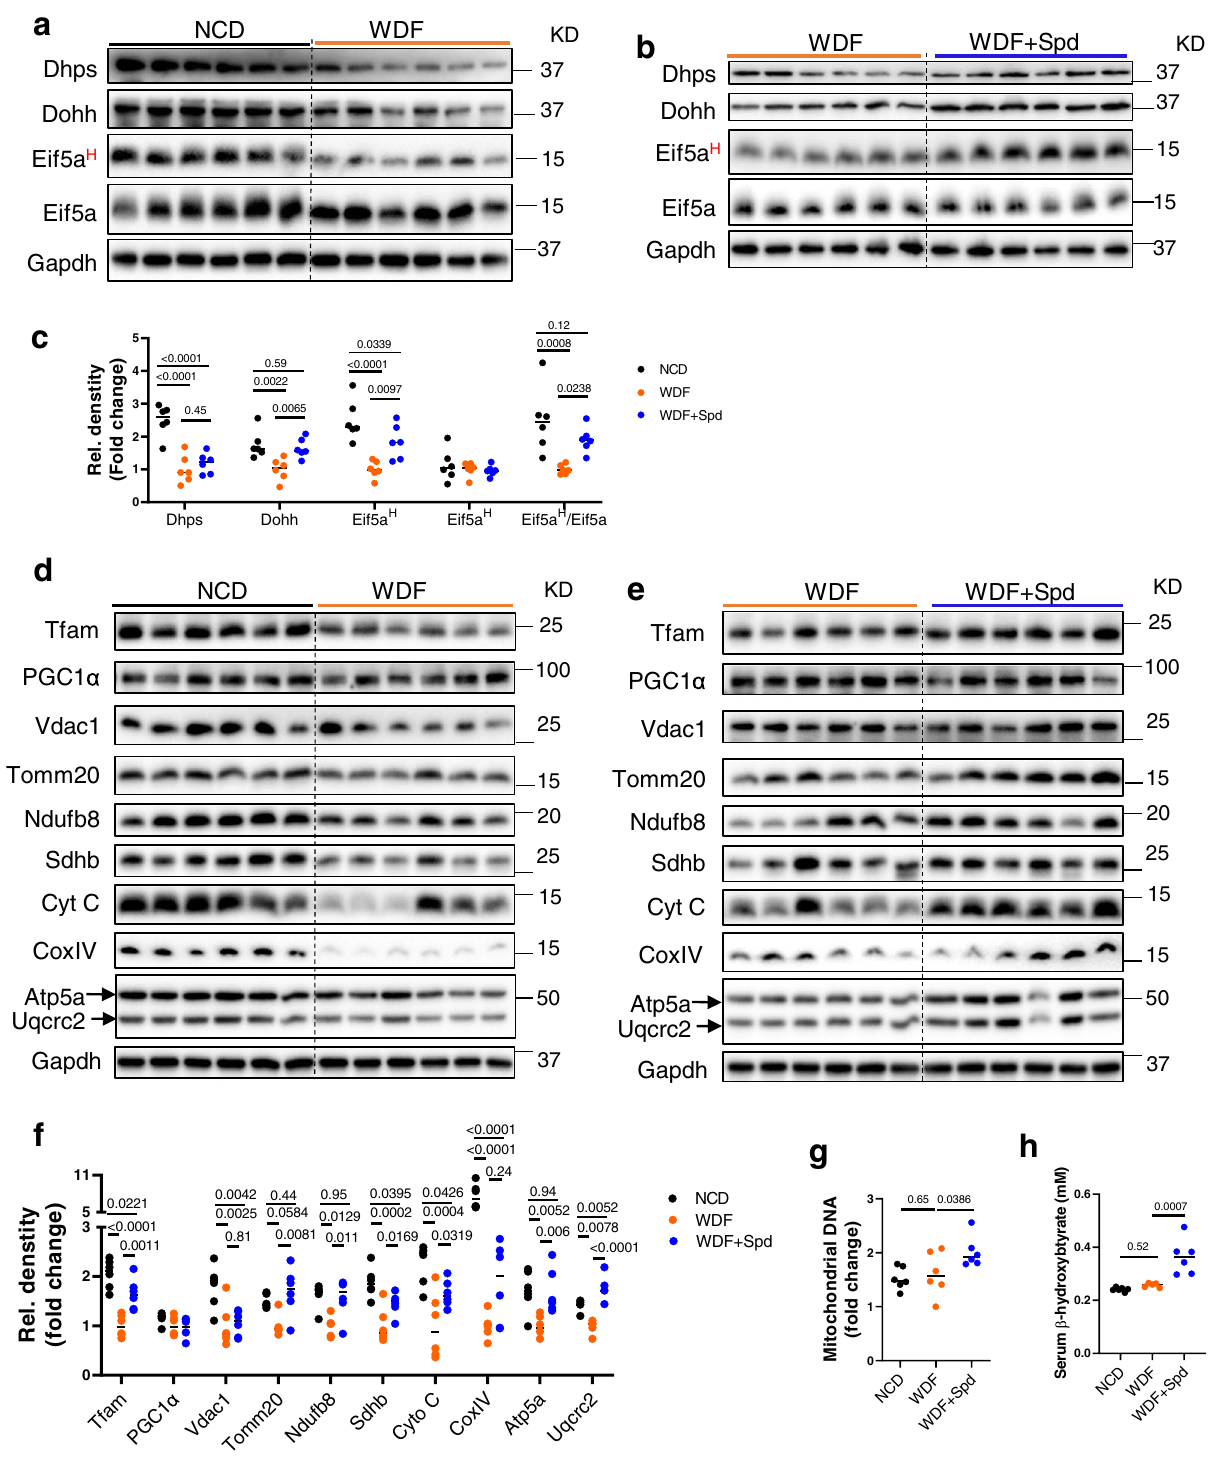
Fig.6|SpermidinesupplementationrestoredhepaticEif5a H andmitochondrial protein levels in a dietary mouse model of NASH. a – c Western blot and densi- tometric analysis of hepatic Dhps, Dohh, Eif5a H , and Eif5a in NCD vs. WDF ( a ), and WDF vs. WDF+Spd (b) mice. The blots in a and b were processed in parallel. Densitometric analysis ( c ) was fi rst normalized with GAPDH, and then calculated the fold change against WDF (NCD vs WDF, and WDF+Spd vs WDF). ( n =6) ( d – f ) Western blot and densitometric analysis of Tfam, PGC1 α , and mitochondrial